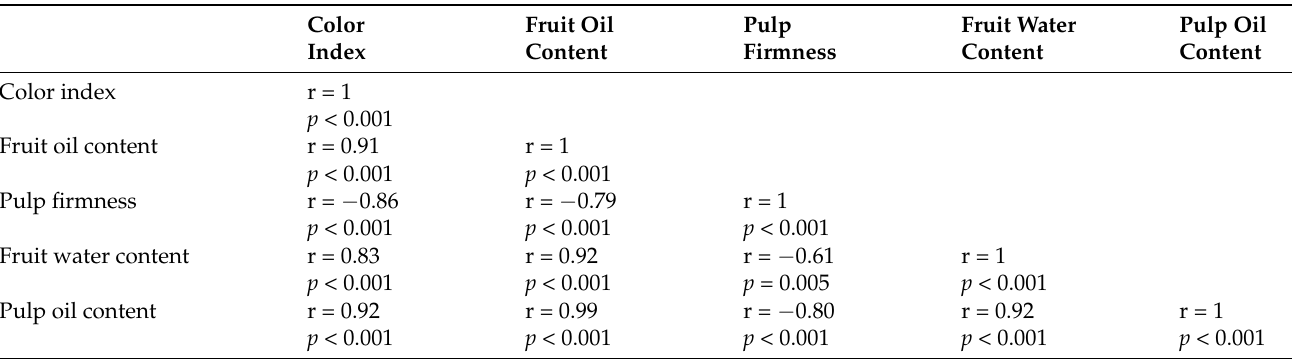
Table 2. Correlation matrix (r, Pearson coefficient; p , significance) among the fruit ripening